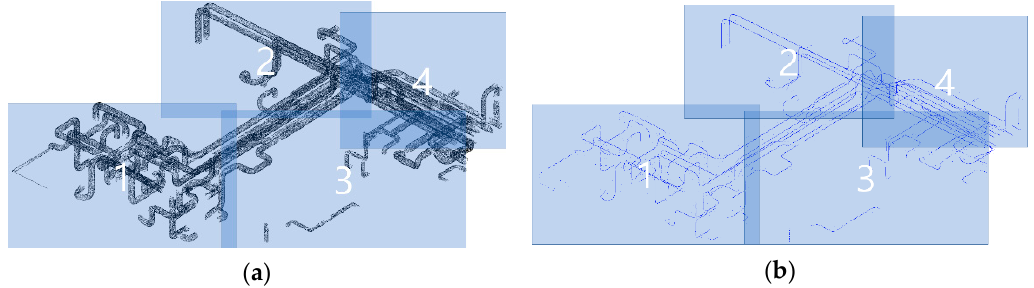
Figure 9. Cylinder estimation with four-core multithreading: ( a ) the point cloud partition for use with four cores and KDTree; ( b ) the central axis estimation and integration for each result.